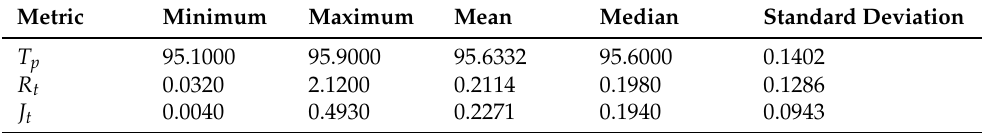
Table 1. Descriptive statistics for T p , R t and J t (over 900 samples) for normal operating scenario.